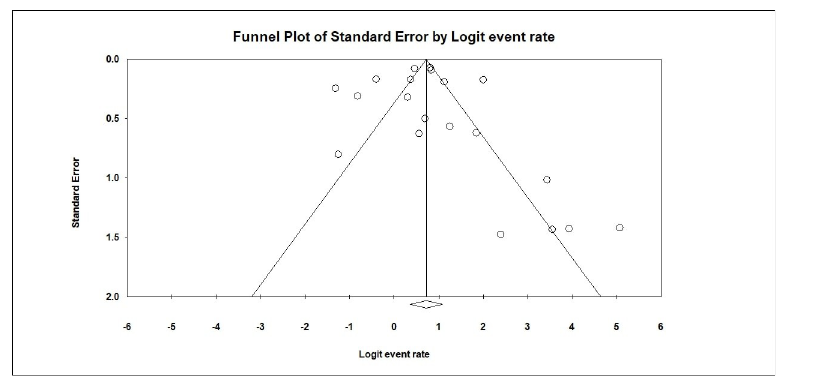
Fig 7. Funnel plot of standard